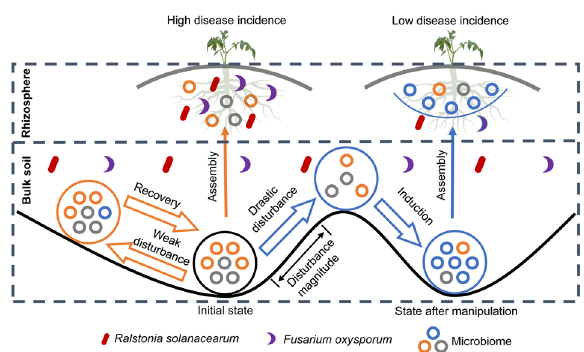
Fig. 6 Main mechanism of soil manipulation targeting multi- pathogen suppression. Orange arrows showed the in fl uence of weak disturbance (bio-organic amendment) on initial microbiome, whereas blue arrows showed the in fl uence of strong disturbance (fumigation) on initial microbiome. When weak disturbance is applied, the microbial community is either resistant or highly resilient to the changes, subsequently returning to initial diseased state. While after fumigation, the initial state of microbiome is drastically perturbed, ensuring the development of an alternative community composition that develops into a healthy soil micro- biome in response to organic amendments, achieving low disease incidence in subsequent plant